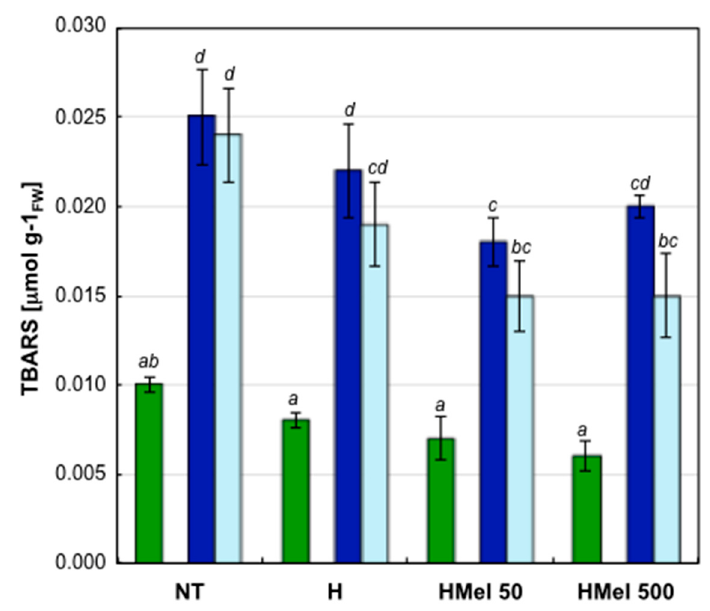
Figure 4. Effect of different maize seed hydropriming treatments on TBARS accumulation in the axes isolated from the non-treated seeds (NT), and those from hydroprimed with water (H) and with melatonin water solutions in concentrations: 50 µ M (HMel 50) and 500 µ M (HMel 500). The seeds were imbibed/germinated in water at 5 °C in darkness for 14 days (S [ ■ ]—chilling stress), and subsequently regenerated at 25 °C for 1 day (R [ ■ ]—regeneration). TBARS were also estimated in axes isolated from the seeds germinated for 24 h under optimal conditions 25 °C (C [ ■ ]—optimum, control conditions). The results are expressed as means of 6–9 measurements ±SEM. Two-way ANOVA and Duncan’s post-hoc tests were performed. The lowercase letters next to the values show statistical significance at the specified p . TBARS—ANOVA results: Seed Variant (NT,H,HMel 50,HMel 500) F (3;84) = 6.57, p < 0.000001; Conditions (C,S,R) F (2;84) = 44.07, p < 0.000001; interaction Seed Variant × Conditions F (6;84) = 0.80, p = 0.57 no statistical significance.